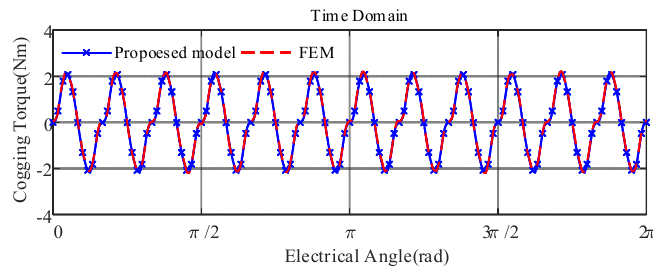
Figure 6. Comparison results of the cogging torque.